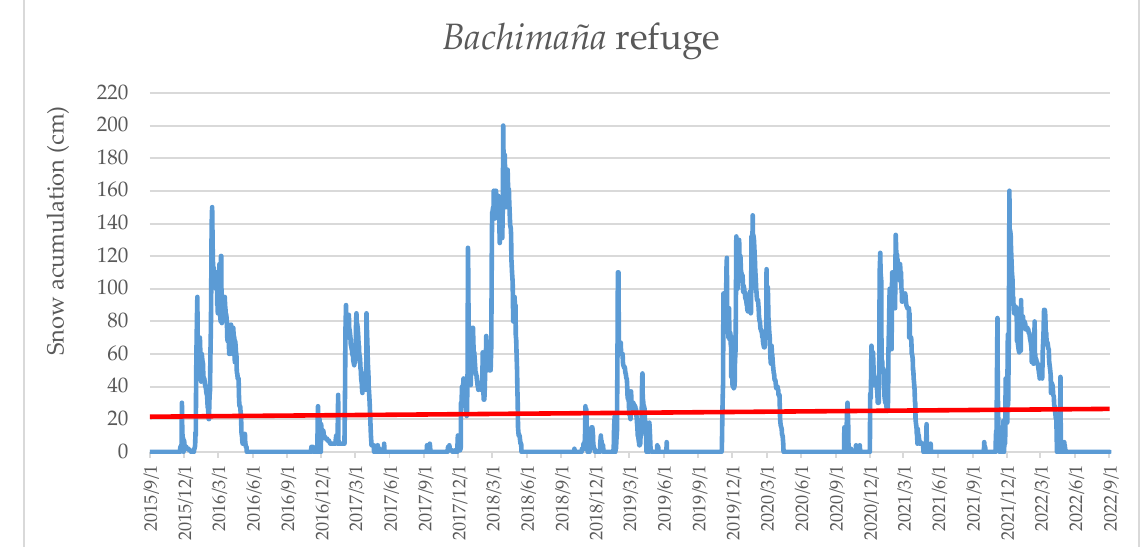
Figure 13. Evolution of snowpack thickness at the Bachimaña refuge, weather station (2200 m a.s.l.). September 2015 – September 2022. Trend line (red). Base data: daily snow depth. Data source: AEMET [50].